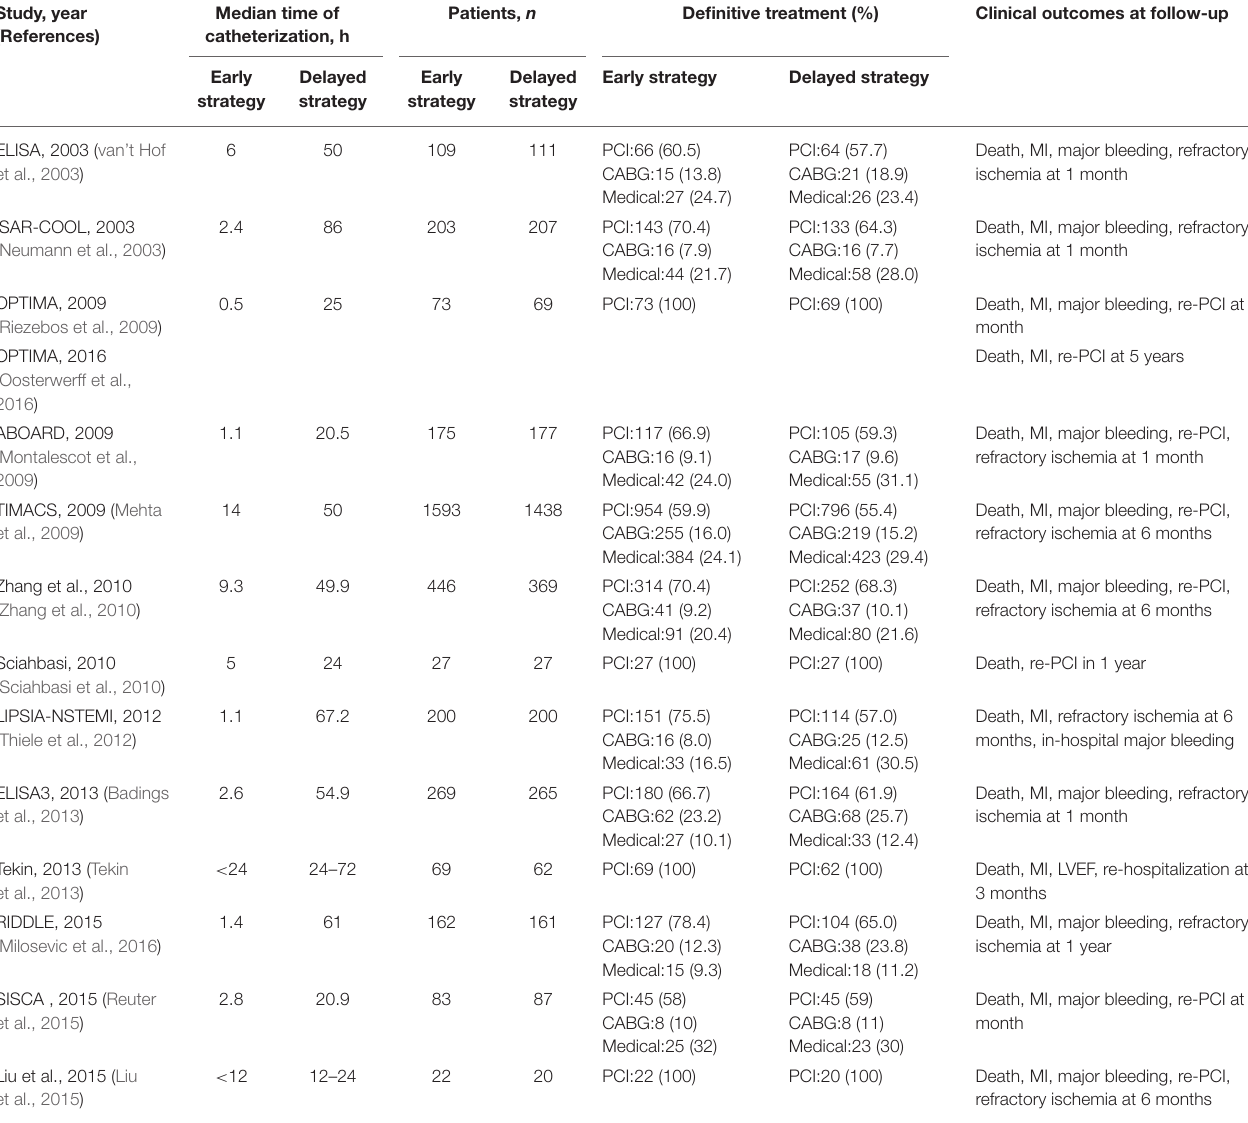
TABLE 1 | Timing of the invasive approach, definitive treatment, and clinical outcomes at follow-up for included RCTs comparing early and delayed strategies. Study, year Median time of Patients, n Definitive treatment (%) Clinical outcomes at (References) catheterization, h